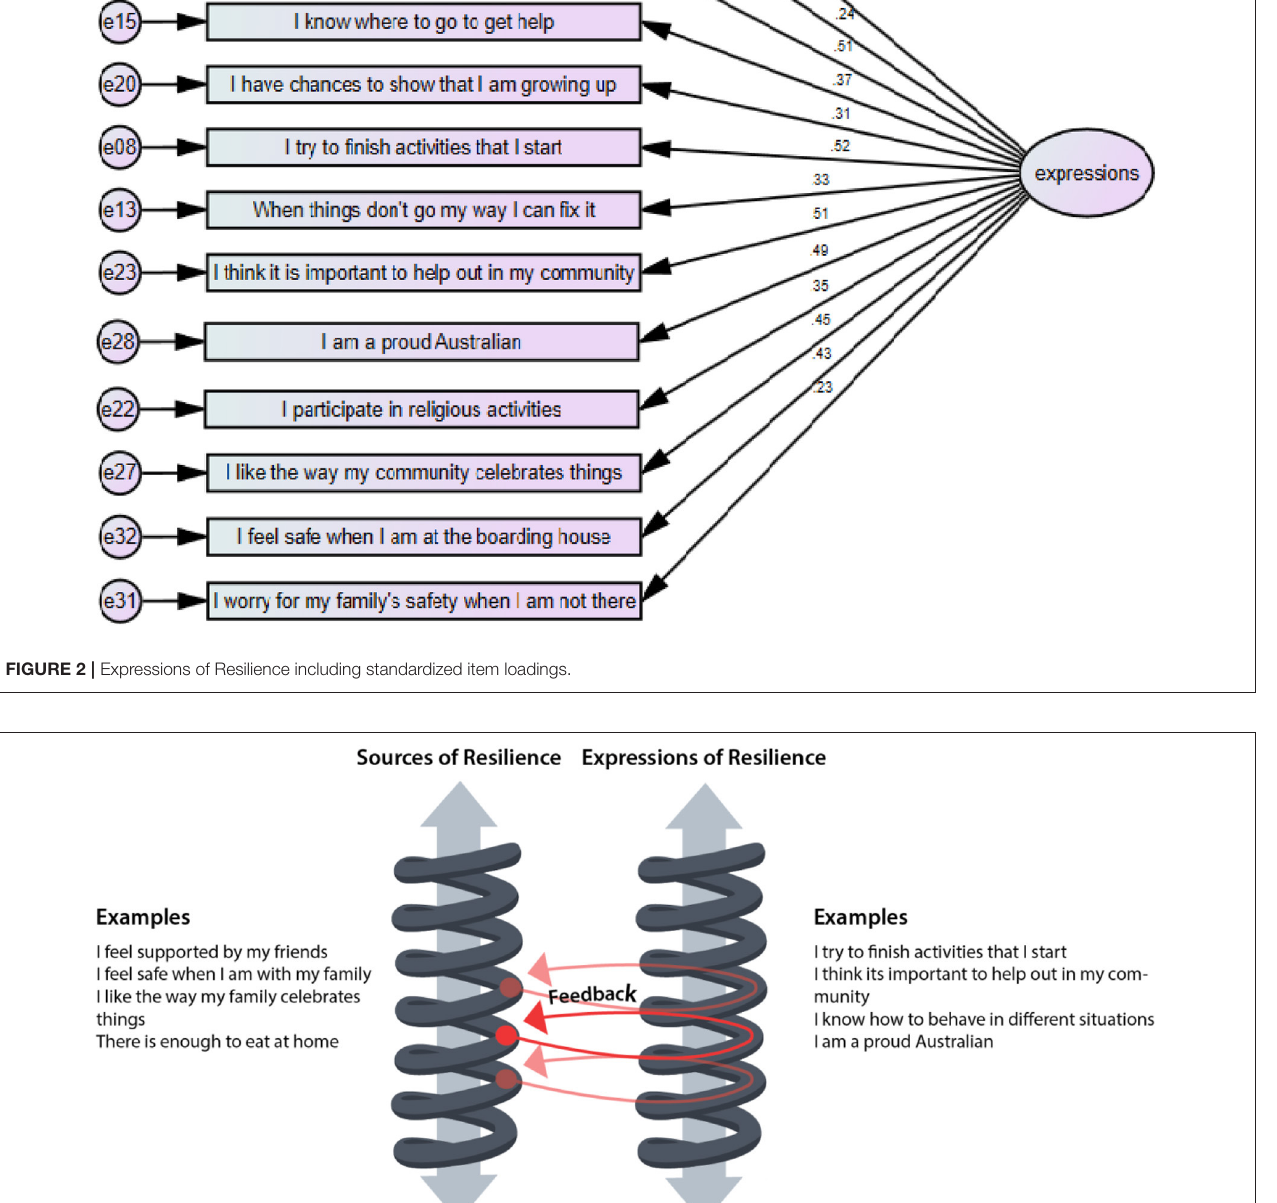
resilience in youth has been previously identified (41). The differences in the influence of family and friends as sources of resilience between age groups suggests that there is